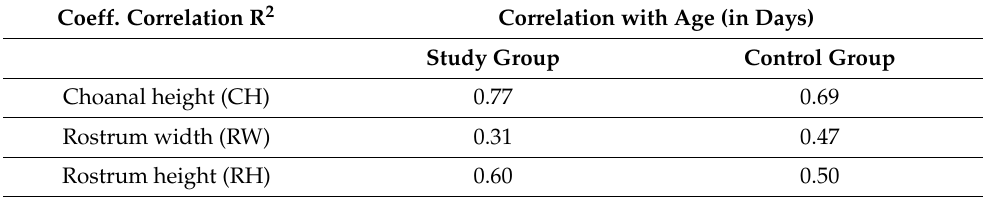
Table 4. Pearson ’ s correlation coefficient. Table 4. Pearson’s correlation coefficient. Coeff. Correlation R 2